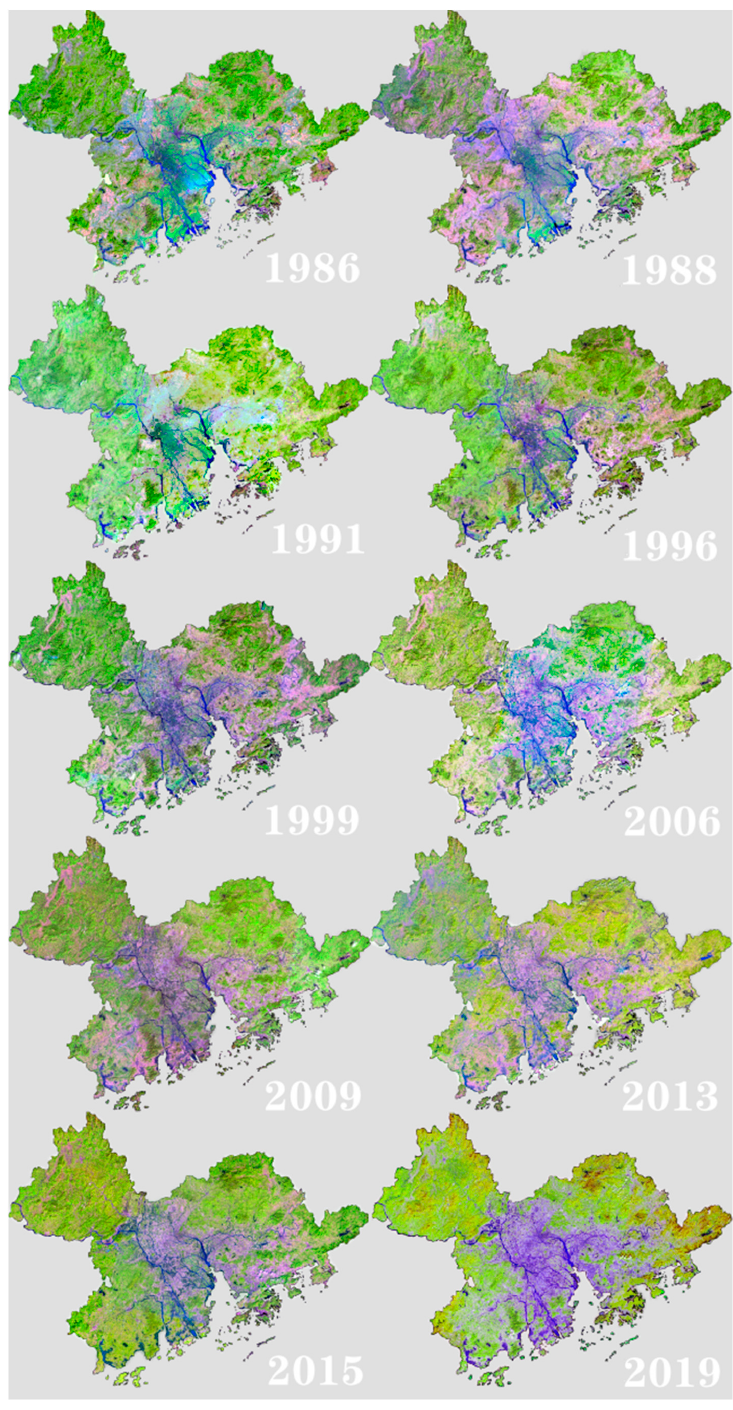
Figure 5. Pre-processed Landsat images for the 10 study periods.